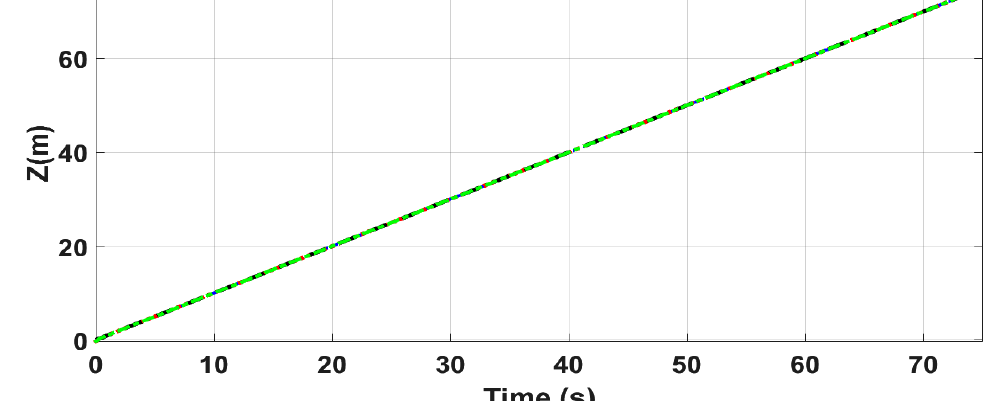
Figure 18. z tracking.